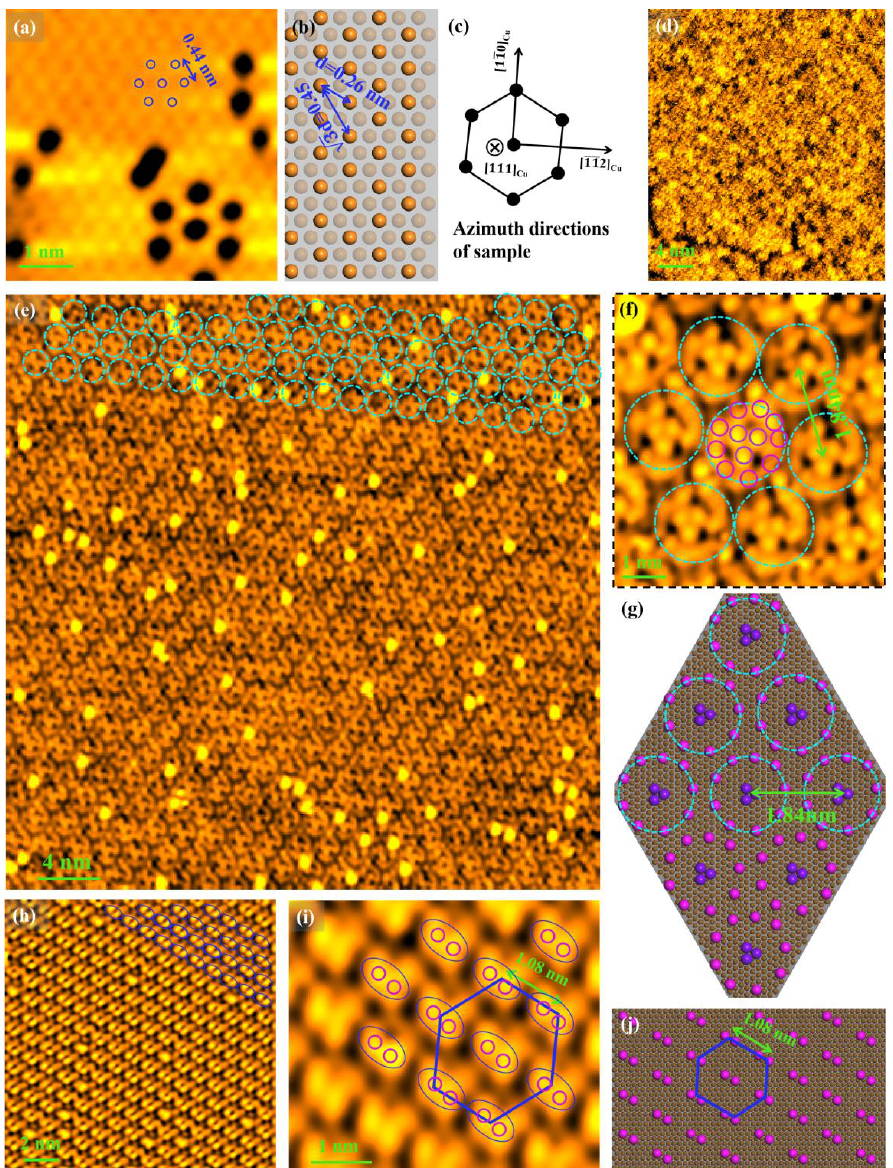
Figure 5. Surface structures of Process Ⅱ . ( a ) ( √3 × √3 ) R30° reconstruction; ( b ) the atomic model of the Cu(111) surface, the double-blue arrows label the nearest (0.26 nm) and next-nearest (0.45 nm) atom distances, ( c ) [1 1̅ 0]Cu, [ 1̅1̅ 2]Cu, and [111]Cu azimuth directions of the sample according to the sample information; ( d ) a higher-resolution STM image from the triangle island region in Figure 1d; ( e ) a higher-resolution STM image of the smooth step terraces in Figure 1d, ( f ) an STM image with further higher resolution of the circular superstructure, ( g ) the corresponding atomic model in top view; ( h ) another higher-resolution STM image of the smooth step terraces in Figure 1d; ( i ) the STM image with further higher resolution of Figure 5h, the ellipses represent the double-atom structures, ( j ) the atomic model in top view. The blue hexagons of Figure 5i and j indicate the hexagonal sym- metry of the superstructure. Here, the scanning bias voltage and current are equal to 0.5 V and 0.1 nA, respectively.